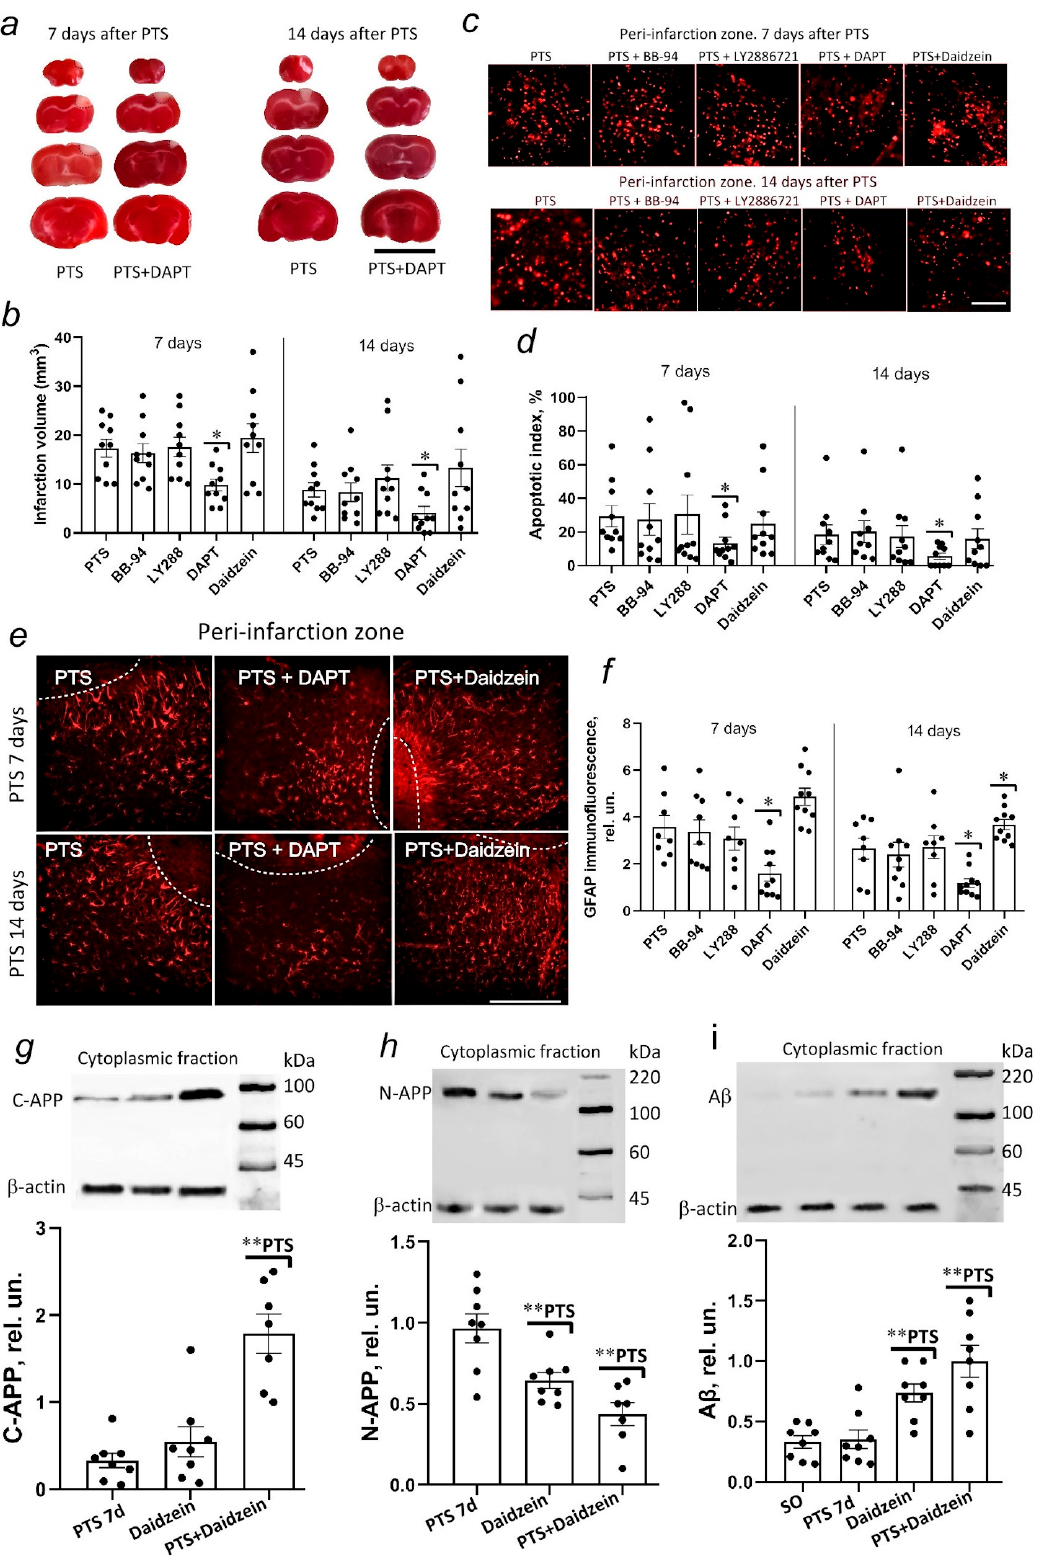
Figure 8. Effects of secretase inhibitors (LY2886721, an inhibitor of β -secretases BACE1 and BACE2; DAPT, an inhibitor of γ -secretase) and daidzein, an inhibitor of caveolin-1, on the volume of the infarction nucleus, apoptosis, and expression of GFAP in the peri-infarction region in the mouse cerebral cortex on days seven and 14 after PTS. ( a ) View of the mouse brain slices seven and 14